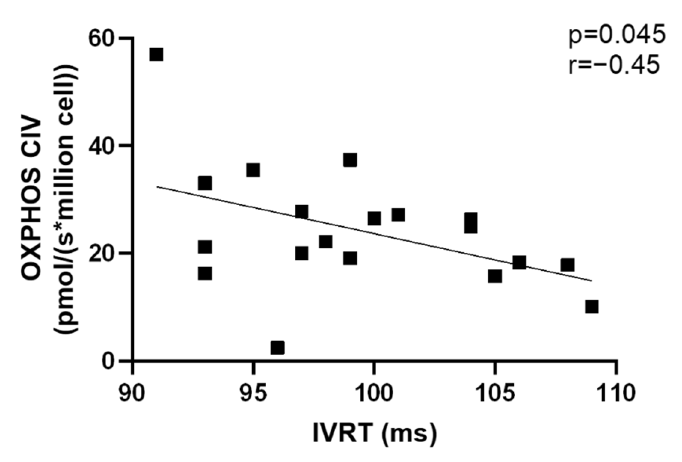
Figure 6. Correlation between OXPHOS CIV and IVRT. IVRT: Isovolumic Relaxation Time.